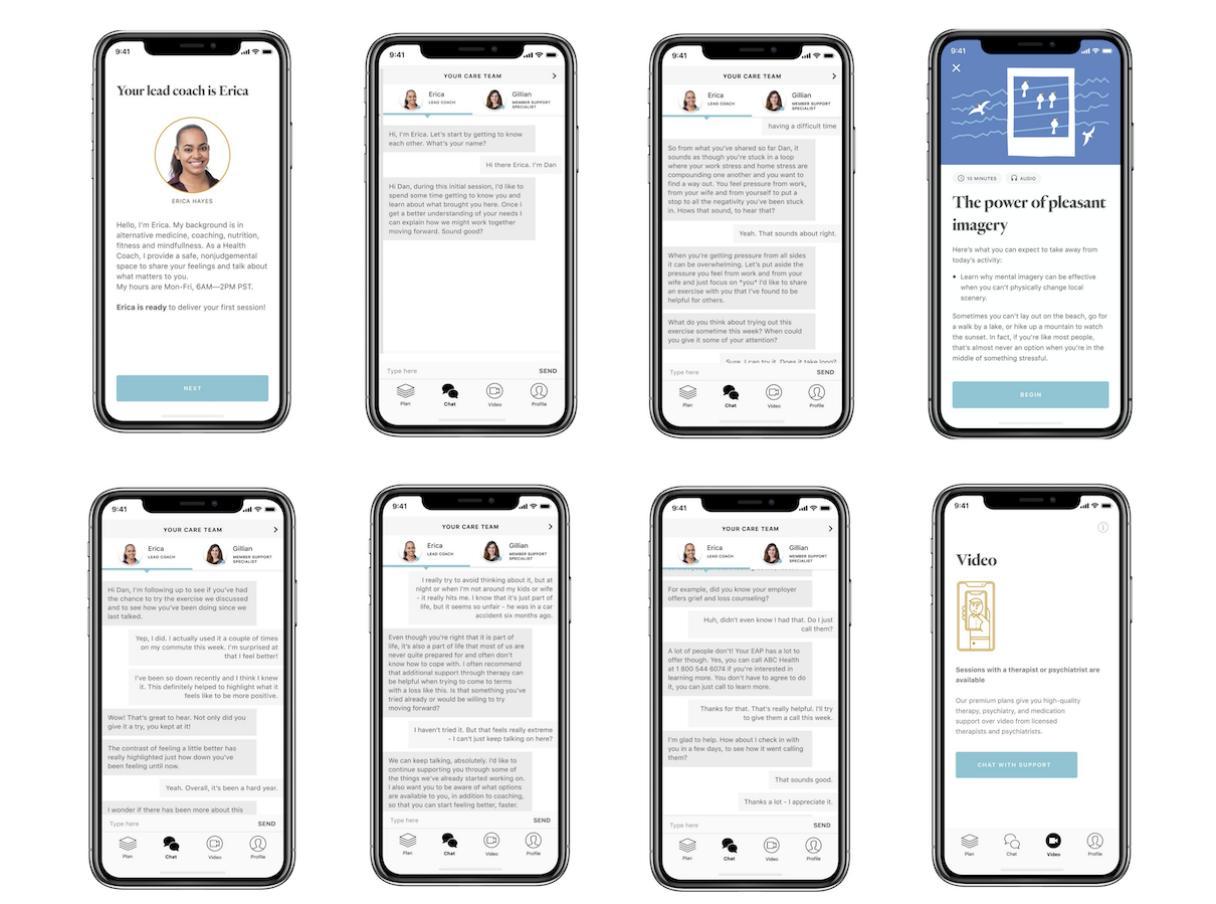
Figure 2. Ginger coach chat